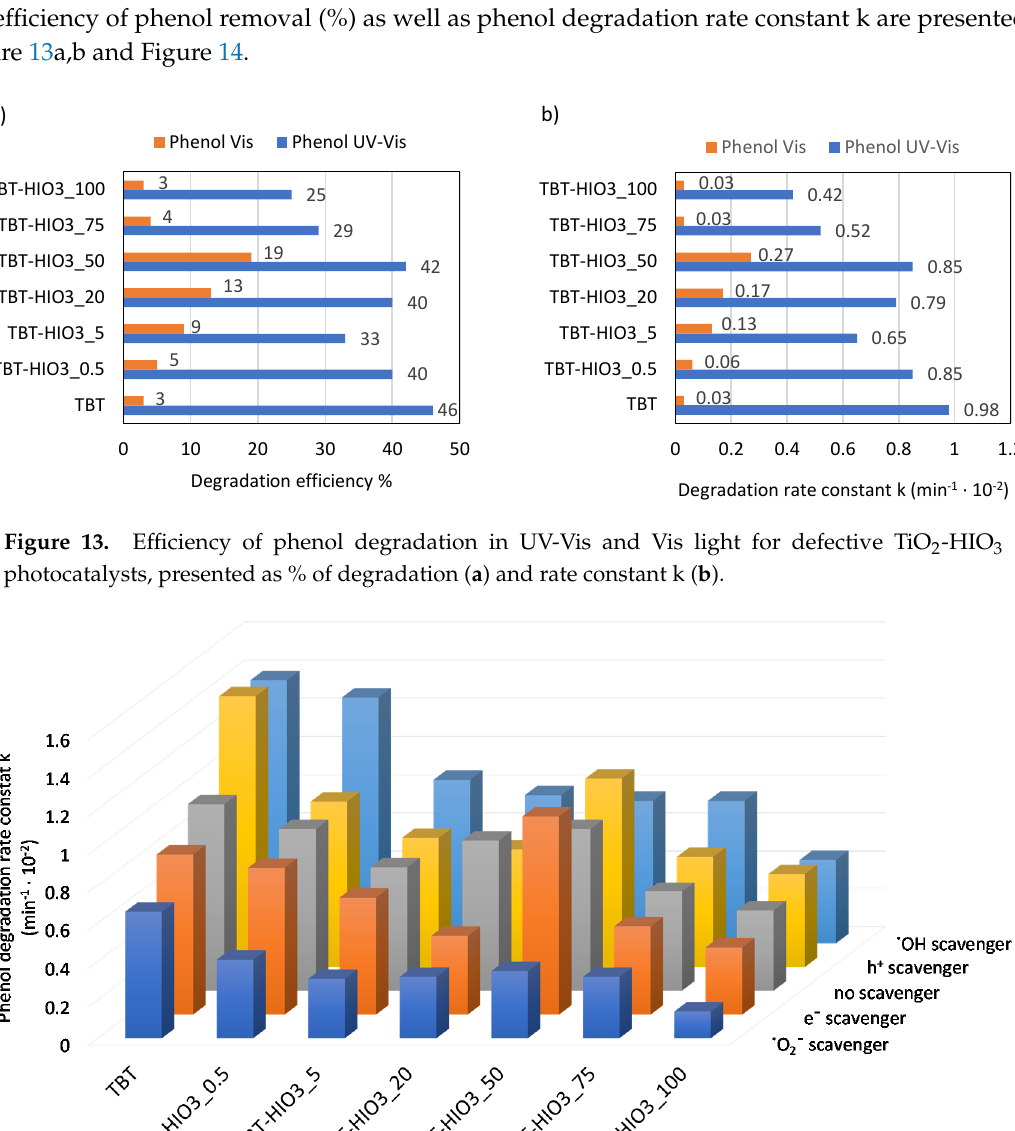
15 of 25 Figure 12. XPS analyses spectra for TBT-HIO 3 _20 sample ( a ) with the I 3d states binding energy enlargement ( b ). As mentioned in the literature [62–64] I 3d states are in the range of 620 – 635 eV. However, as it could be seen in Figure 12b, there is no peak, which could be assigned to I 3d states. In this regard, for TBT-HIO 3 samples changes in physicochemical and, what is the most important, photochemical properties are caused by intrinsic defects, not titania doping with impurities.